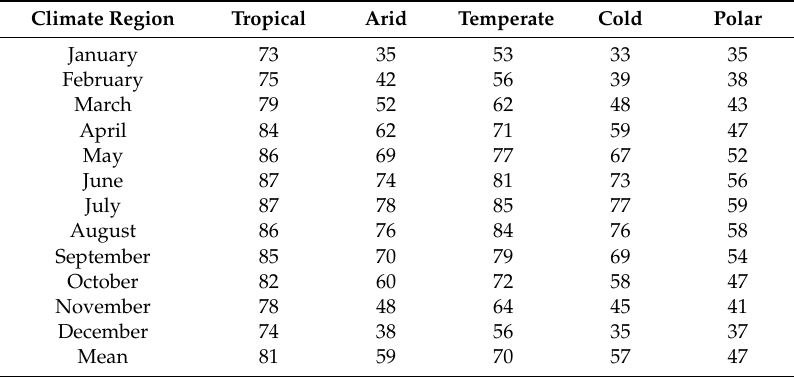
Table 1. Descriptive statistics for temperature–humidity index (THI) values.